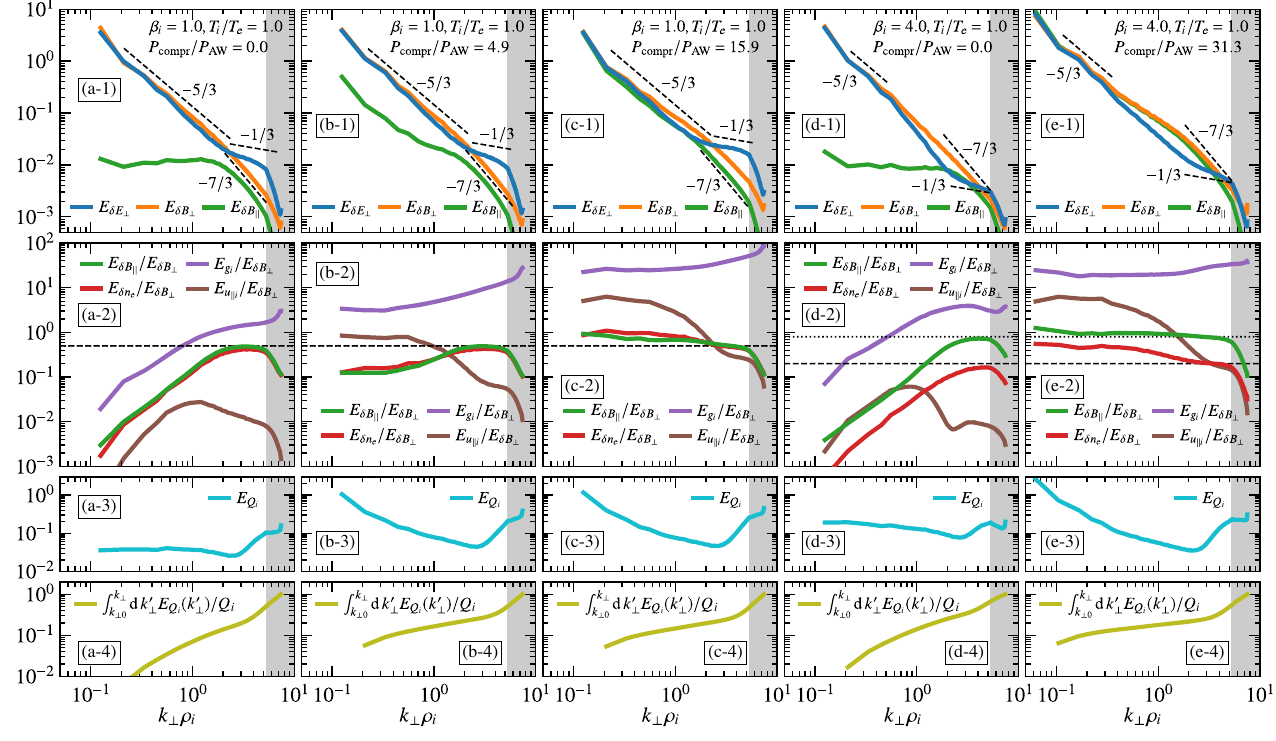
W δ where W δ is the total perpendicular i B ⊥ B ⊥ Q Q Q where Q is the total heating rate. Bottom row: the ion-heating-rate spectrum i i þ e tot tot ¼ 1 , (d-1) – (e-4) β 4 , and P =P . Parameter values: (a-1) – (c-4) β is increased from i i ¼ i ¼ compr AW ; k plane. The results shown in (a-1) – (d-4) and (e-1) – (e-4) are x y Þ